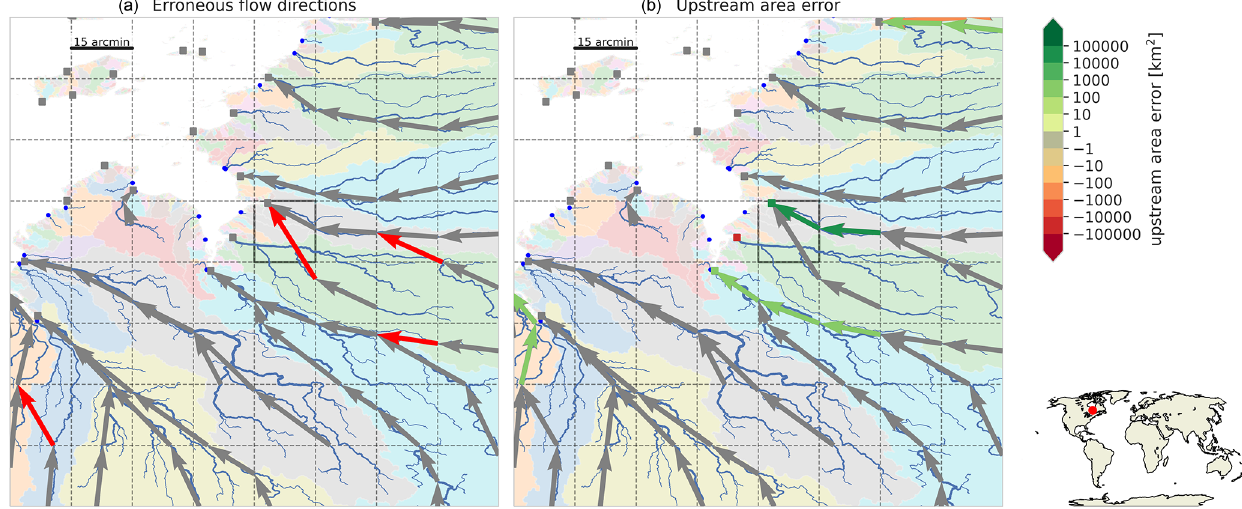
Figure C3. Largest basin (914km 2 ) with a relative upstream area error of more than 10% at the 30arcsec resolution indicated with a highlighted cell. See the caption of Fig. C1 for a full description.